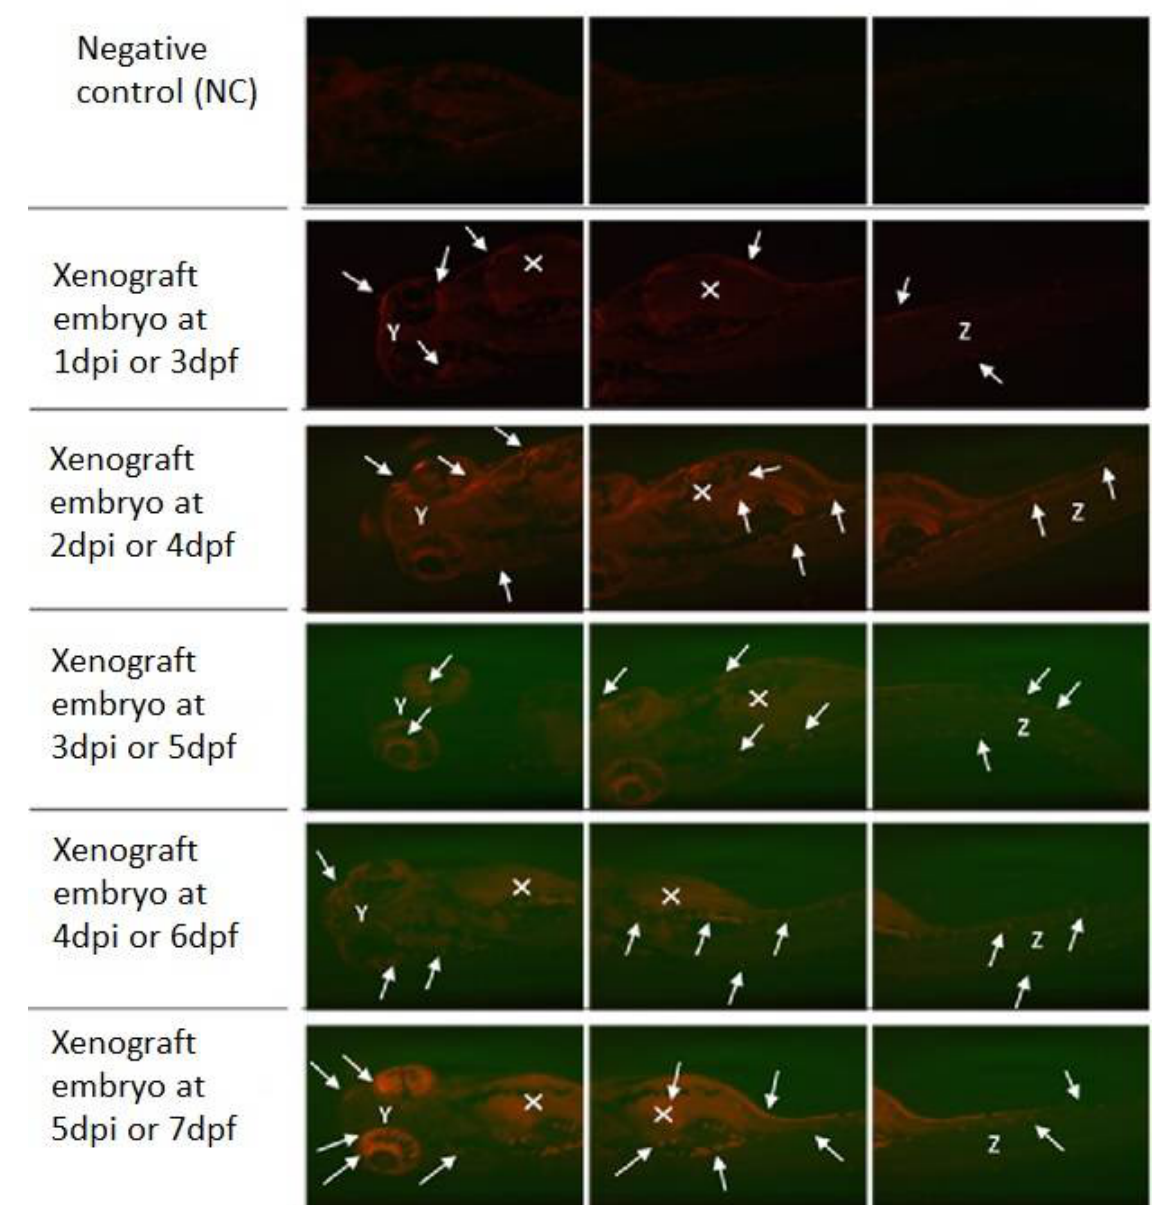
Figure 8. Zebrafish Xenograft model injected at 2 dpf. Representative fluorescence images of zebrafish screening at 3 dpf to 7 dpf using fluorescent microscopy and investigation of fluorescent K562 cells proliferation (white solid arrows) throughout the animal body (Y—eyes; X—yolk sac; Z—tail) using mCherry fluorescence filter. Original magnification 100×.